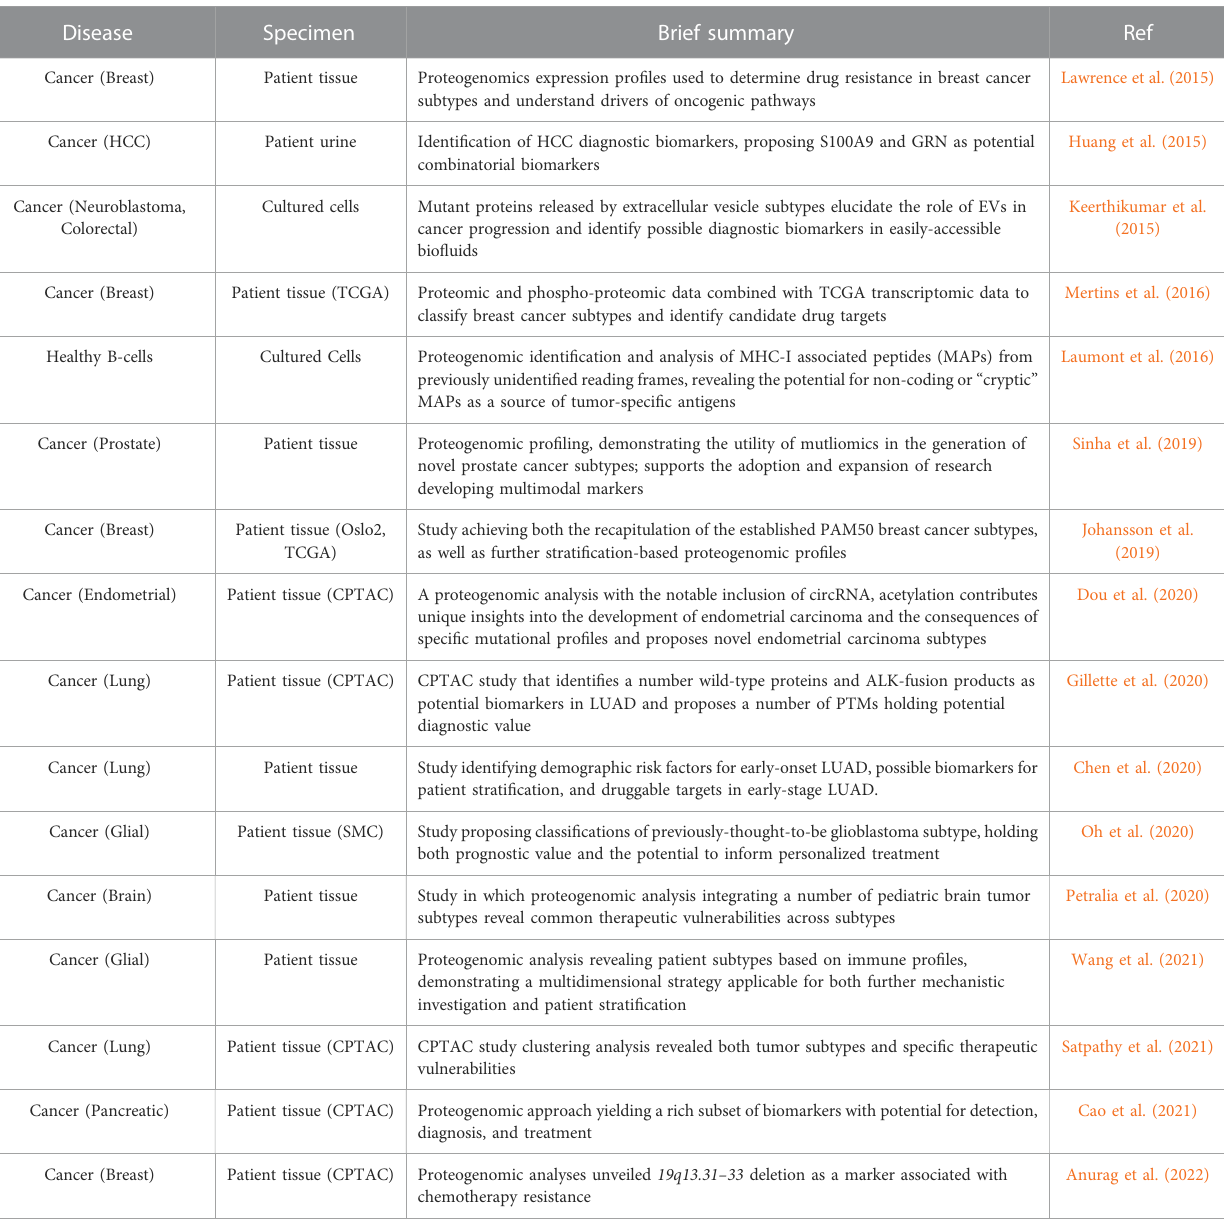
TABLE 1 Integrated proteogenomic analyses lead to cancer biomarker discovery.